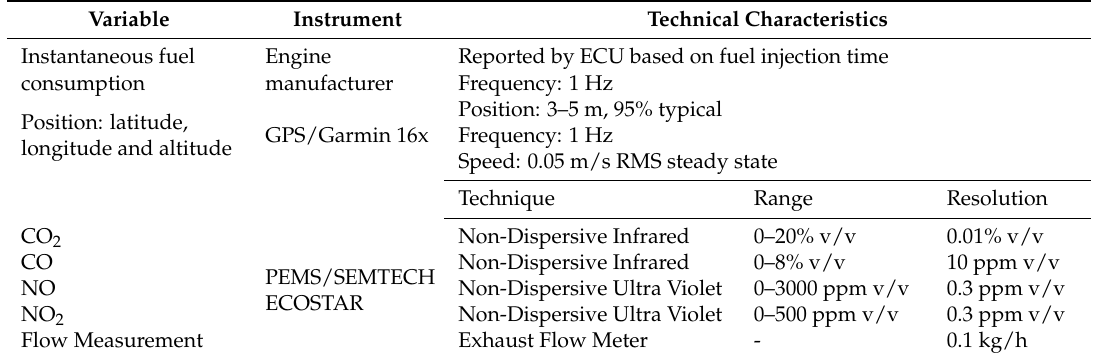
Table 2. Technical characteristics of the instruments used in this work